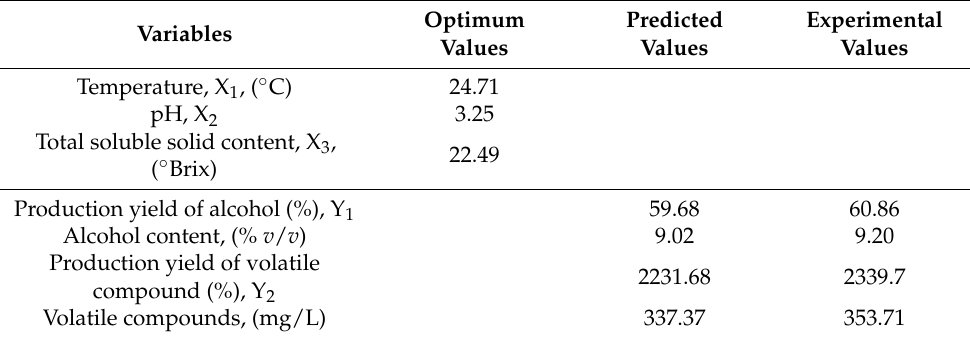
Table 5. Estimated optimum values and predicted, experimental values of